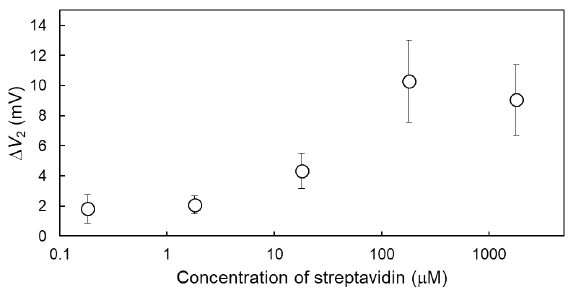
Figure 5. ∆ V 2 at various streptavidin concentrations. The concentration of streptavidin was varied from 0.18 µ M to 1.8 mM in the 0.1X PBS solution. Each signal was averaged over three measurements (n = 3) with the standard deviation shown as error bars.